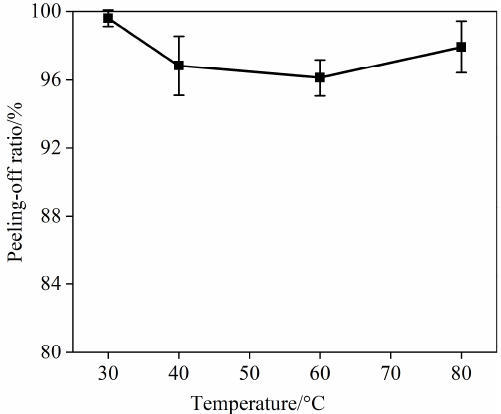
Figure 10. Effect of temperature on peeling-off ratio of ultrasound-mechanical stirrer.